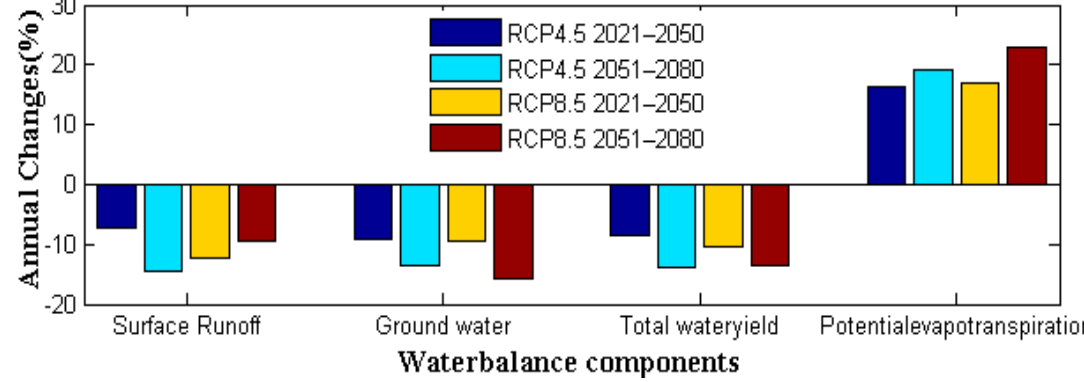
Figure 10. Impacts of climate change on water balance